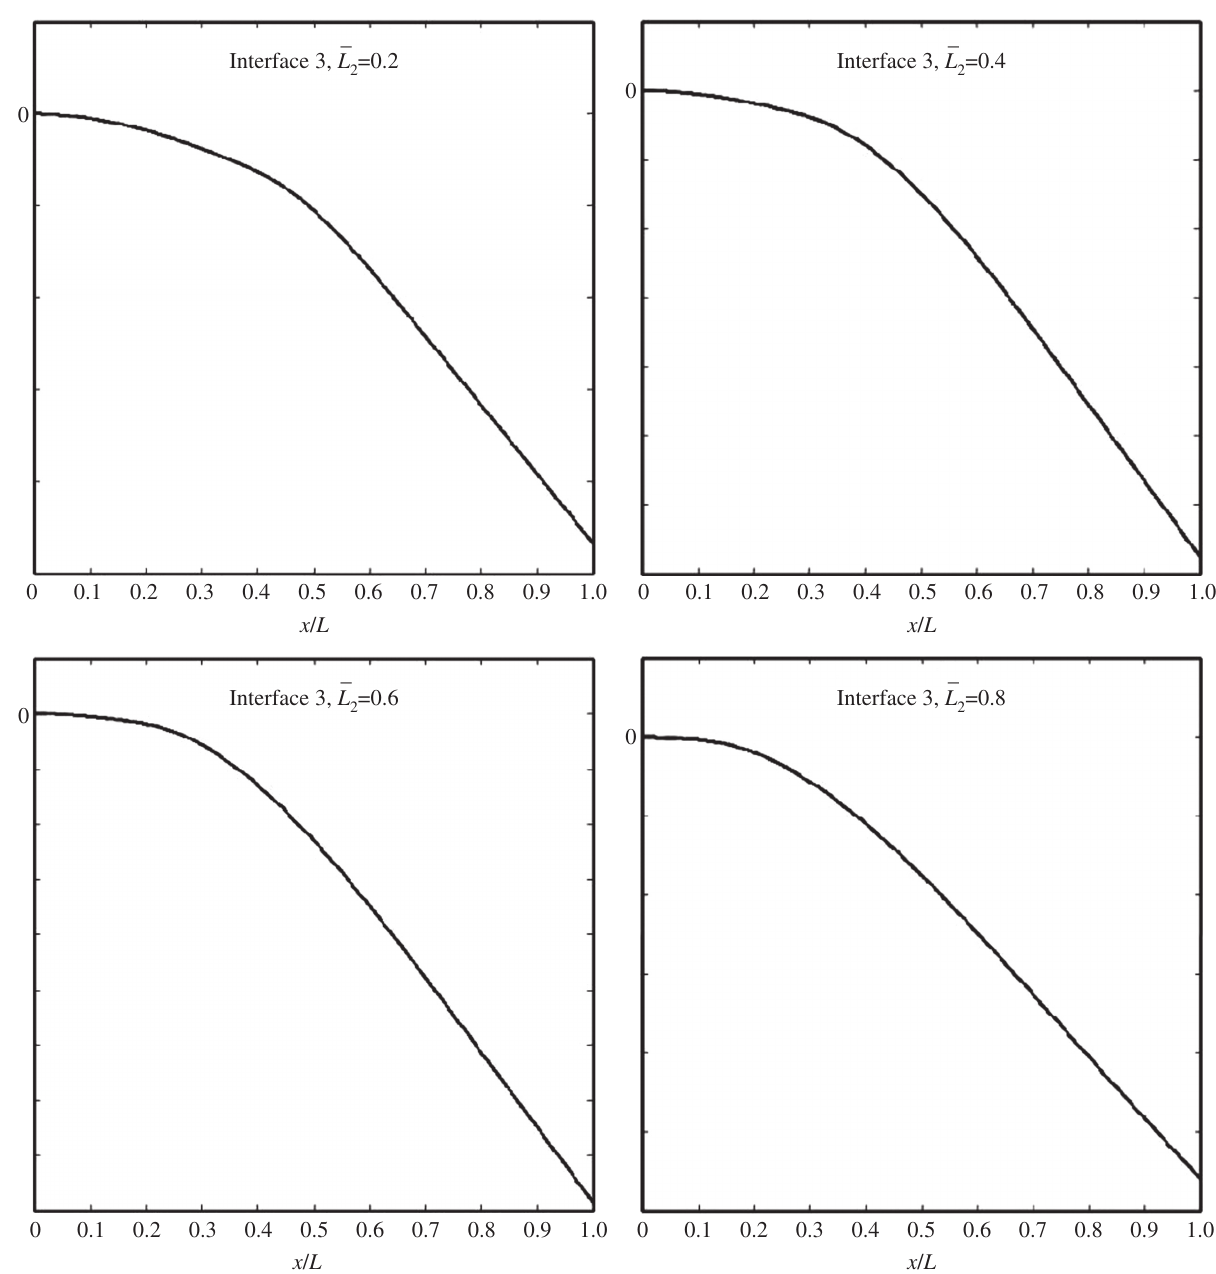
Figure 13 First mode shape of a LCB with delamination located at interface 3 related to four different lengths of delamination.